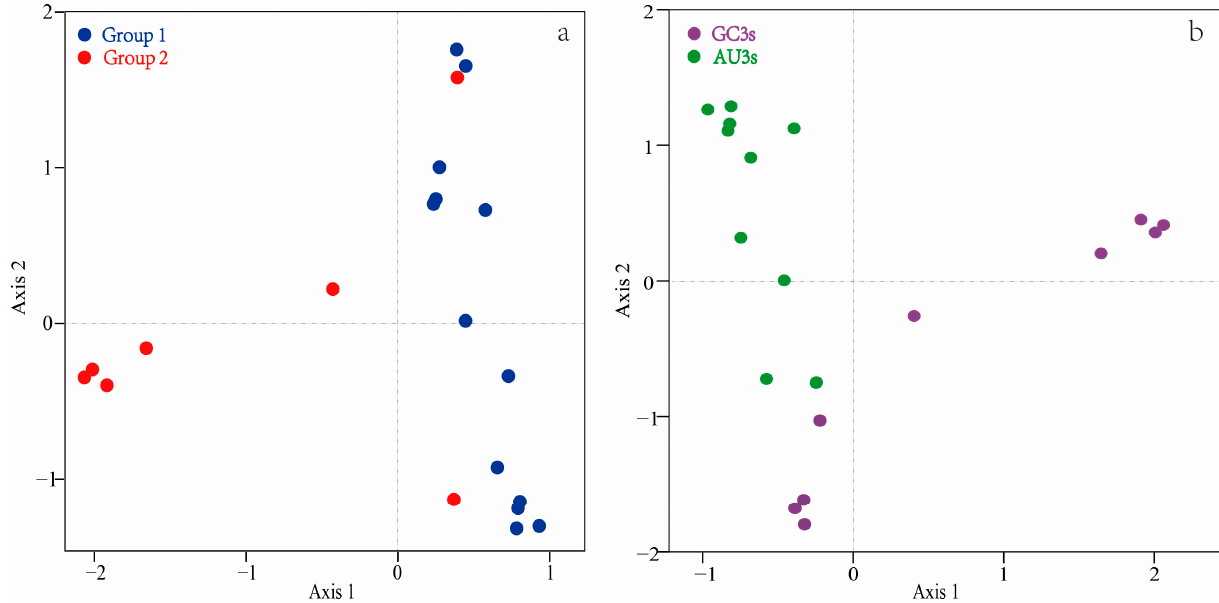
Figure 5. Multiple correspondence analysis of relative synonymous codon usage in the XET genes. Multiple correspondence analysis of Group 1 and 2 in the results of Figure 1 ( a ), multiple correspon- dence analysis of GC3 S and AU3 S ( b